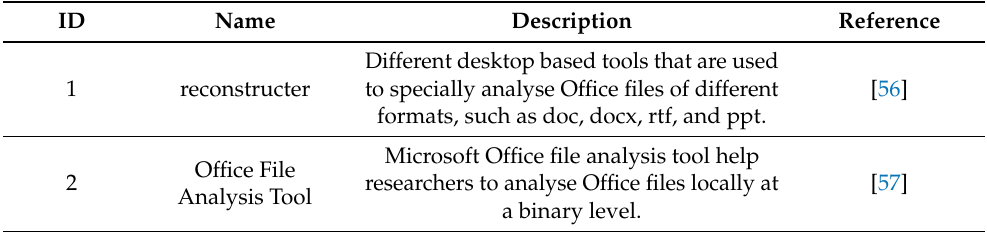
Table 11. Tools used for OSINT on Microsoft Office file analysis.